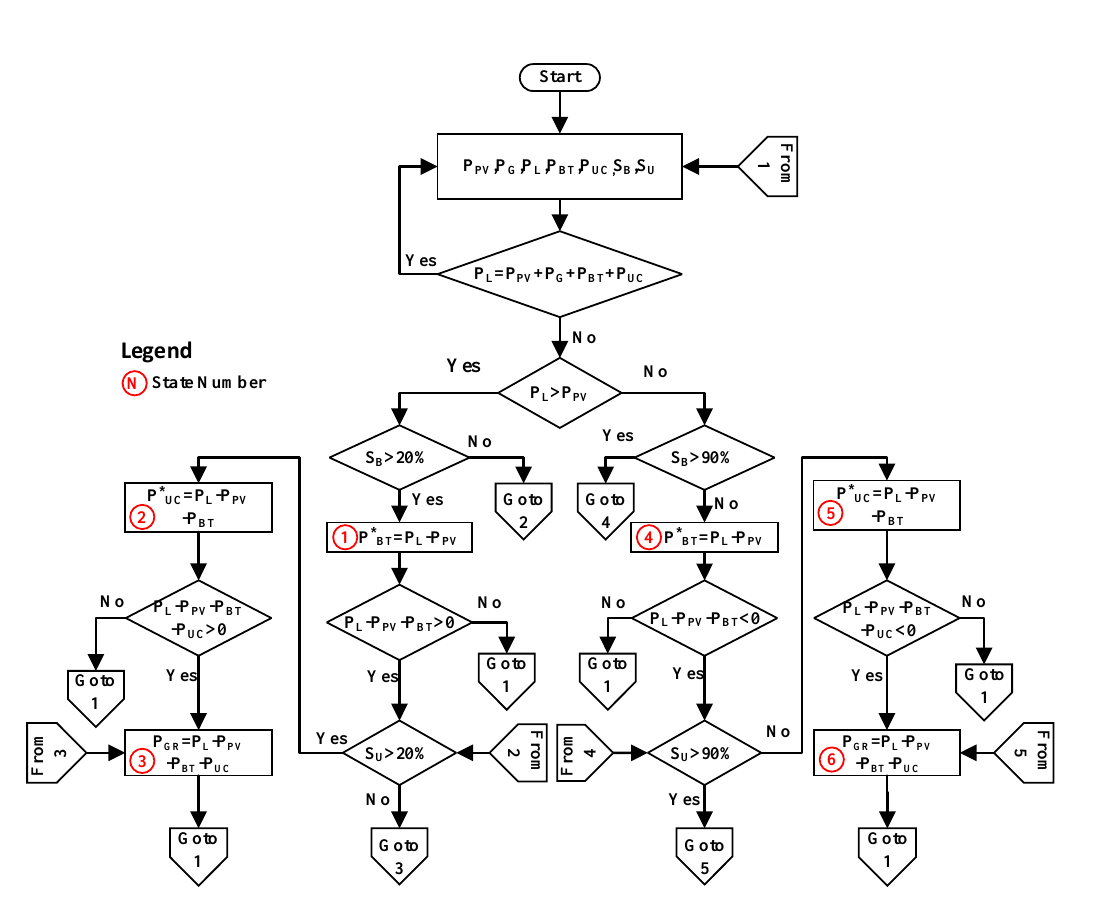
Figure 8. Flowchart of the energy management and supervisory control system (EMSCS).